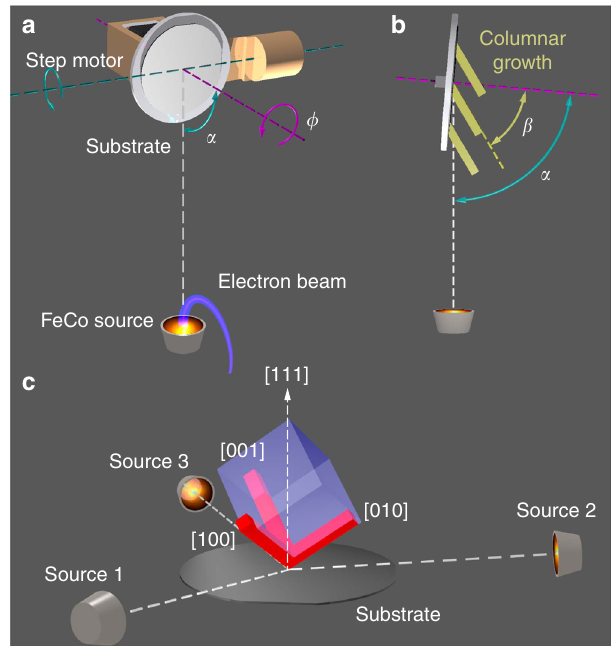
Fig. 1 Control of nanowire crystal orientation by vectorial glancing angle deposition (GLAD). a Schematic of the GLAD setup with de fi nitions for the α and ϕ angles. b The columnar growth results from the ballistic shadowing effect induced at large substrate tilt angles (here α ¼ 85 (cid:2) ). The nanowire tilt angle β is in general smaller than α and related to the crystal structure. c